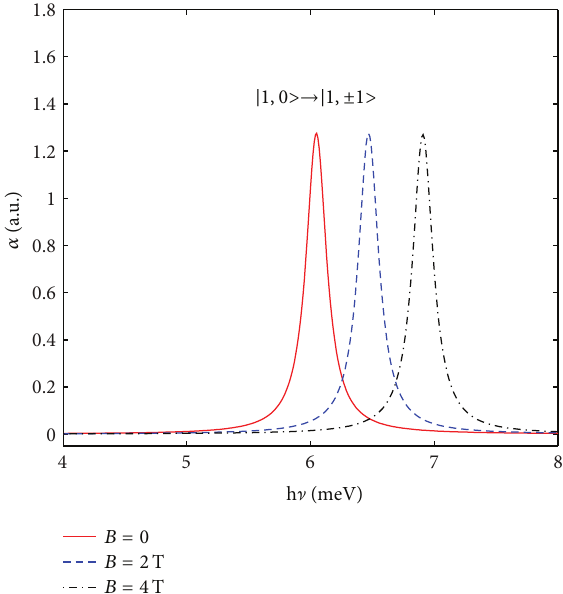
Figure 4: The optical absorption coefficients for transition from ground state to the excited states as a function of the incident photon energy for ℏ𝜔 = 6 meV and different magnetic fields.